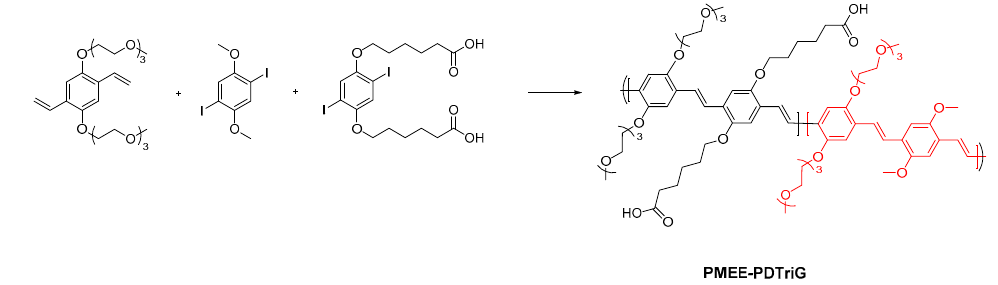
Figure 1. Synthetic scheme of PMEE-PDTriG.